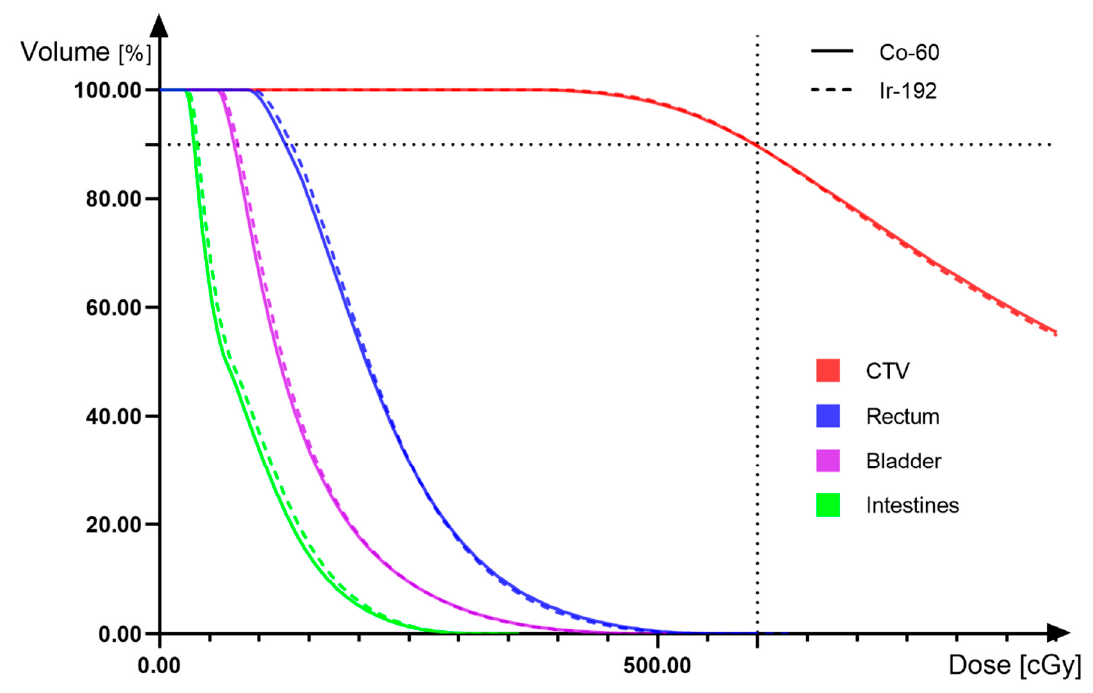
Figure 6. (3D HDR ICBT) Dose-volume histogram comparing 192Ir and 60Co.